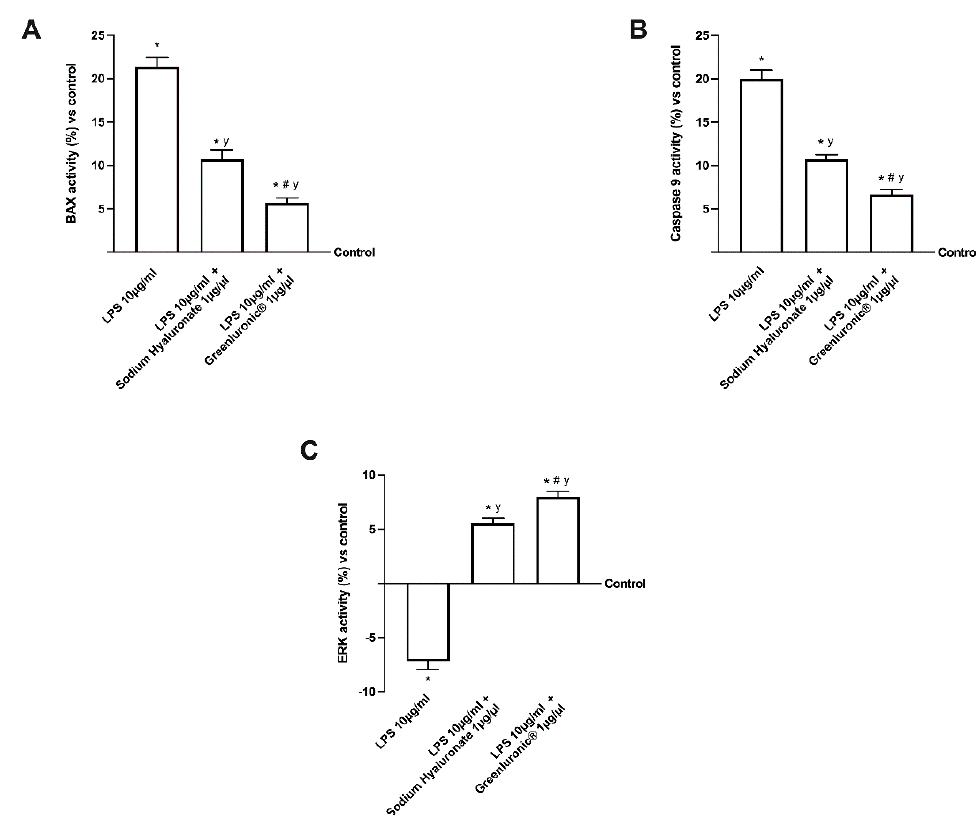
Figure 7. Analysis of the main intracellular pathways activated in T/C-28a2 cells during AO conditions. The results demonstrated a reduction in apoptotic pathways and an improvement of the survival pathways supporting the ability of HA to restore the OA damage. In ( A ) BAX activity; in ( B ) Caspase 9 activity; in ( C ) ERK/MAPK activity; all these results are obtained from specifically ELISA kit. Data are mean ± SD of five independent experiments performed in triplicates compared to the control value (0% line). * p < 0.05 vs. control; y p < 0.05 vs. 10 µ g/mL of LPS; # p < 0.05 vs. Sodium Hyaluronate 1 µ g/ µ